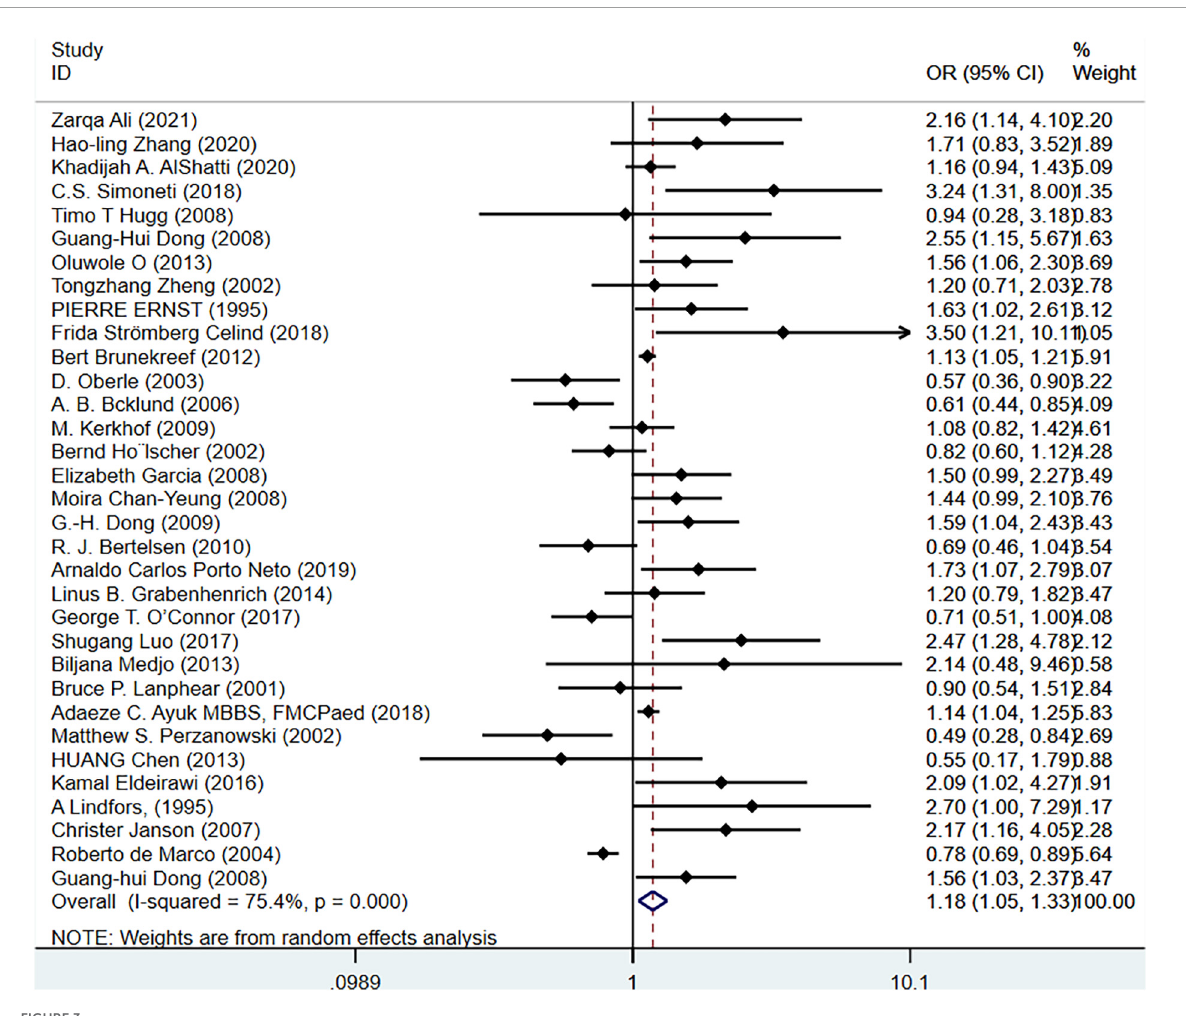
FIGURE3 Forest plot of the association between cat ownership and childhood